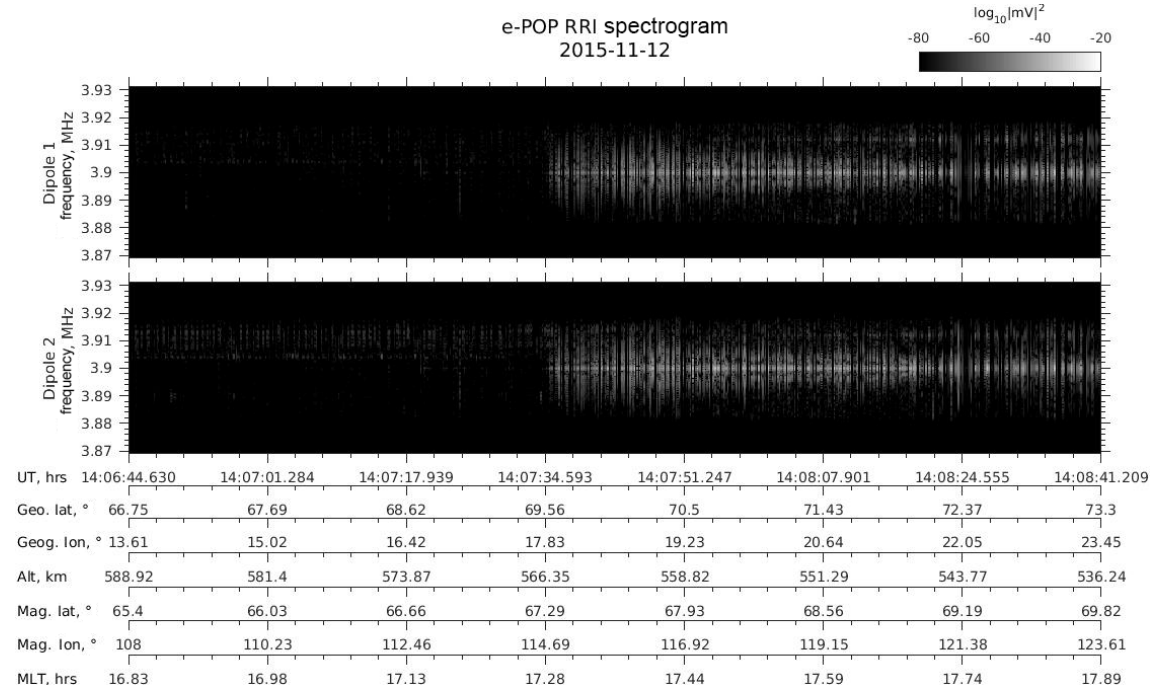
Figure 2. Overview of the detected voltage on the two antenna dipoles for the CASSIOPE passage over EISCAT Heating from 14:06:44.630 to 14:08:41.209UT on 12 November 2015. The RRI was pre-programmed to sweep between 13 different frequency bands, one of which contained the Heating signal at f 0 = 3 . 900MHz. The panels show the signal level in the 60kHz wide frequency band around the Heating signal at f 0 , which can be seen from about 14:07:34UT.